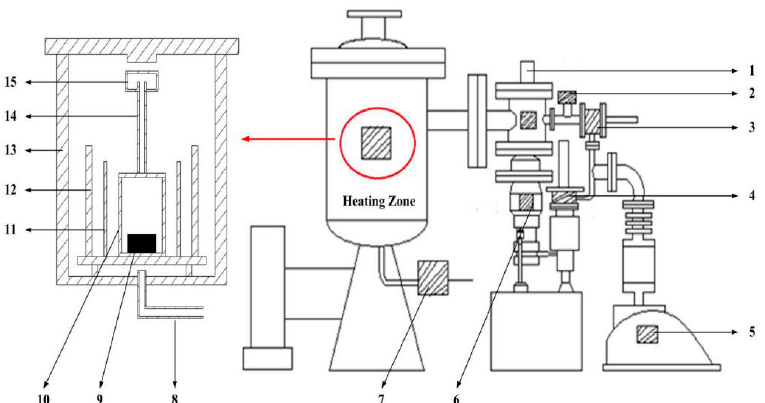
Figure 3. Schematic model of the vacuum distillation furnace: 1, high vacuum valve; 2, release valve; 3, bypass valve; 4, main valve; 5, rotary vane pump; 6, diffusion pump; 7, inflation valve; 8, vacuum pipe; 9, raw materials; 10, graphite crucible; 11, graphite heater; 12, heat shield; 13, water cooled walls; 14, graphite condensing pipe; and 15, condensation.